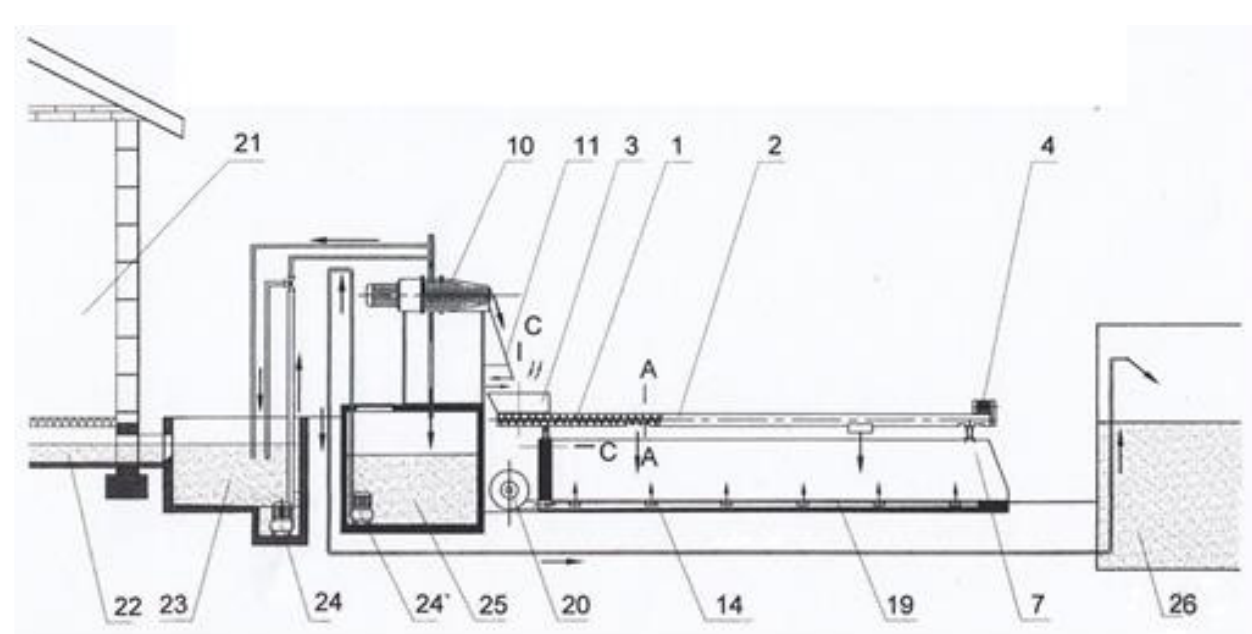
Figure 4. Separation of liquid manure into solid and liquid fractions with a storage system (patent no. P.410755 from 23 December 2014) [2]: 1—a screw conveyor, 2—a tube housing, 3—a hopper basket, 4—a motor with motor reducer, 7—a cell wall (silo), 10—a separator, 11—a trough, 14—a transverse channel, 18—a longitudinal channel, 19—a wide grid,